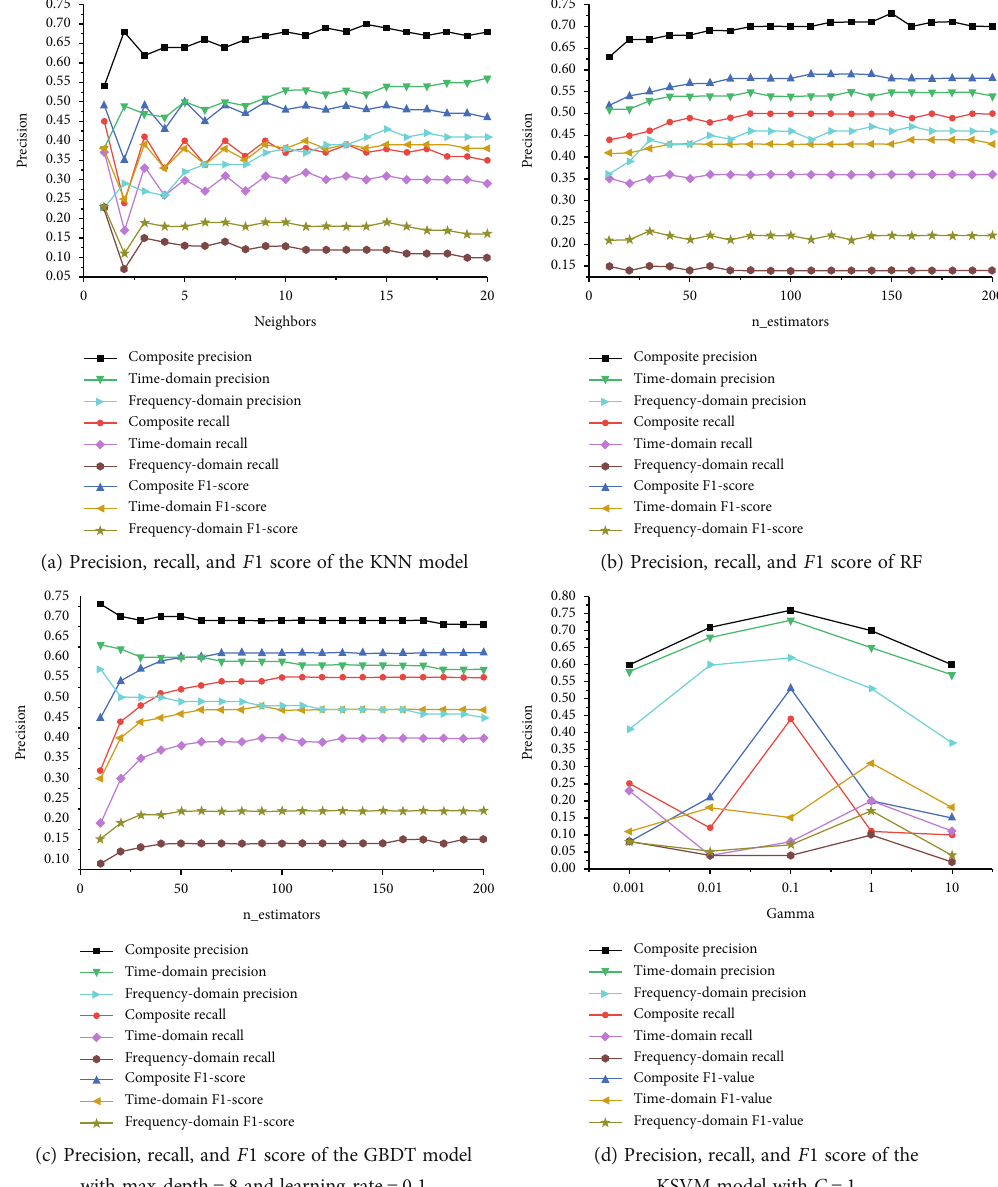
Figure 5: Precision, recall, and F 1 scores of four